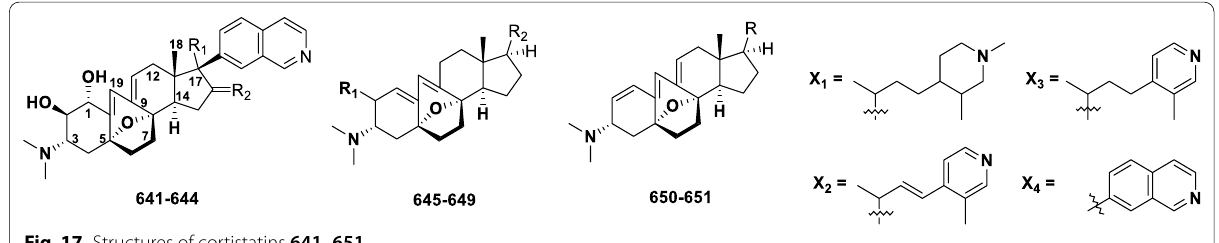
Fig. 17 Structures of cortistatins 641–651